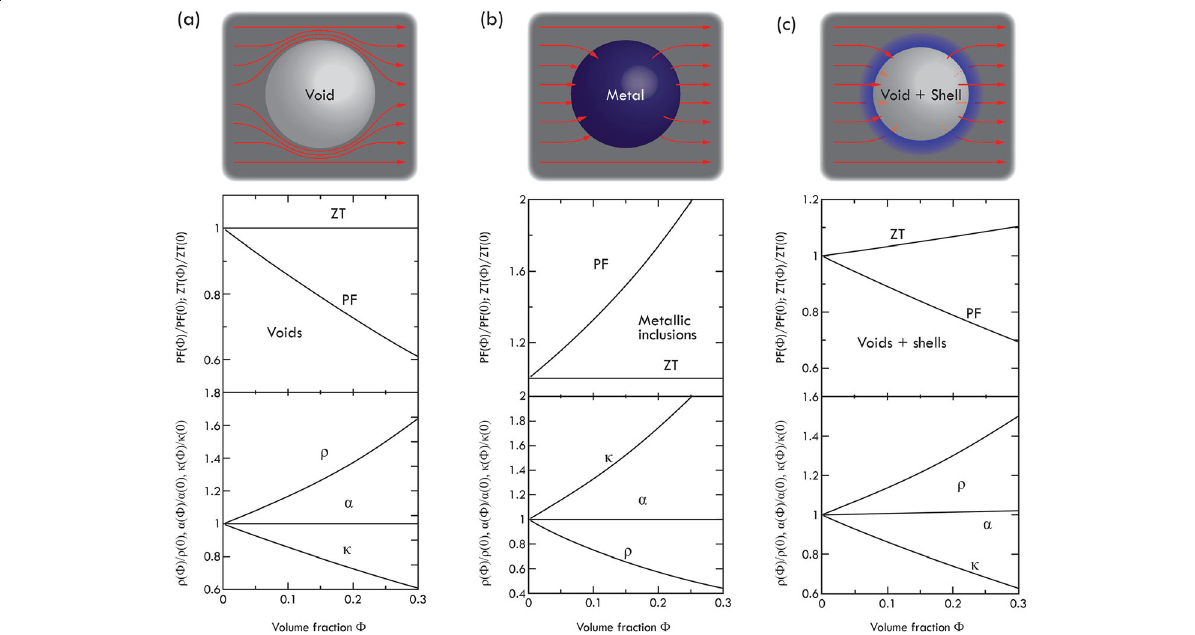
Fig. 1 Results of the effective medium theory ( a ) the case of a spherical inclusion of a void, i.e. a material with no electrical ( σ ) or thermal ( κ ) conductivity in a thermoelectric host (gray); ( b ) the case of a metallic inclusion with an electrical and thermal conductivity 1200 times that of the host, but no thermopower ( α ); ( c ) the case of a void surrounded by a doped layer of thermoelectric with a 100 times higher σ and κ than the host. At filling fractions Φ below the percolation threshold, the thermopower α ( Φ ) of the effective medium is unchanged. In cases ( a ) and ( b ), the effective medium κ ( Φ ) and σ ( Φ ) (shown normalized to those of the host) vary with Φ in complementary ways, and the ZT of the composite is unchanged from that of the host. However, in case ( c ) an increase of ZT can be